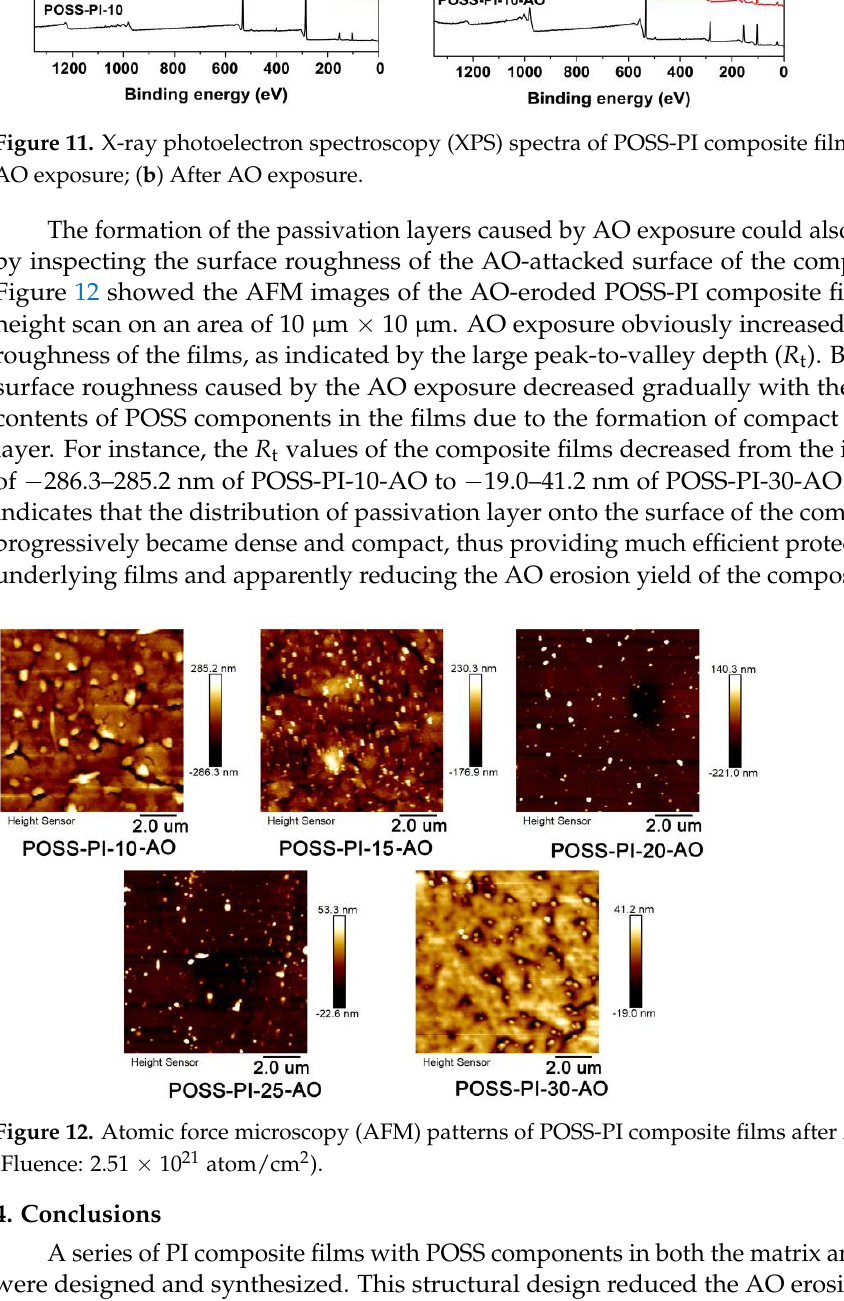
Figure 11. X-ray photoelectron spectroscopy (XPS) spectra of POSS-PI composite films. ( a ) Before AO exposure; ( b ) After AO exposure. Table 4. XPS results for the unexposed and exposed POSS-PI composite films.